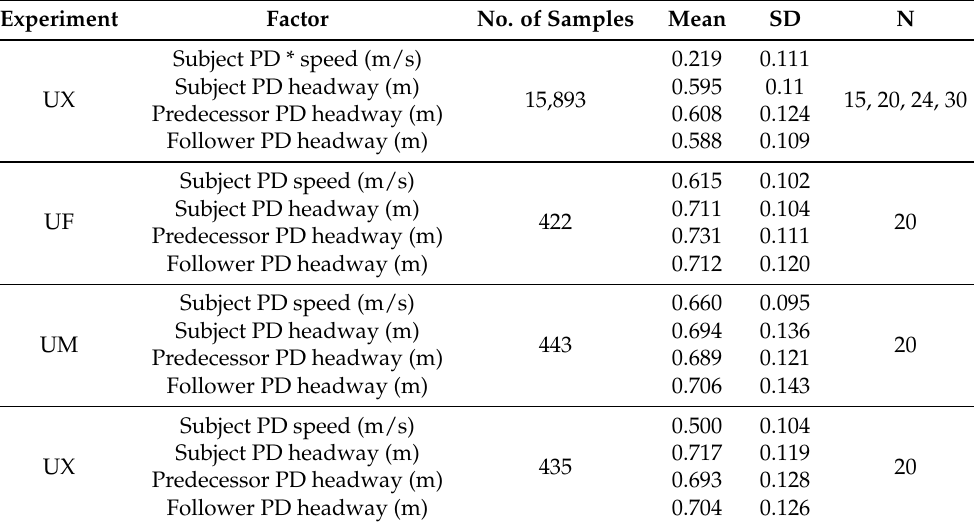
Table 1. This table shows the descriptive statistics (number of pedestrians (N), mean, and standard deviation) for the Palestine dataset [26]. The second column contains the inputs and output that are used for the proposed